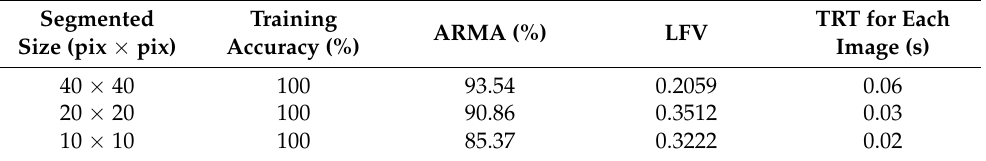
Table 3. The recognition model training results based on different image sizes.